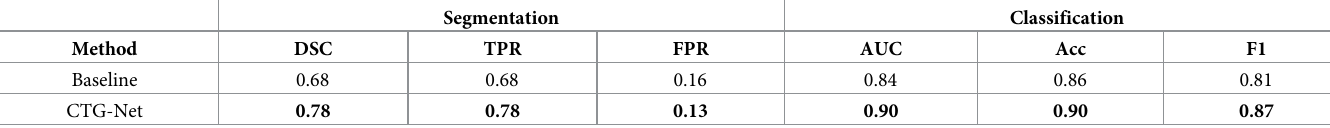
Table 5. Quantitative results for CTG-Net and baseline (i.e., CTG-Net without any task-specific feature extraction module) on the THH dataset.